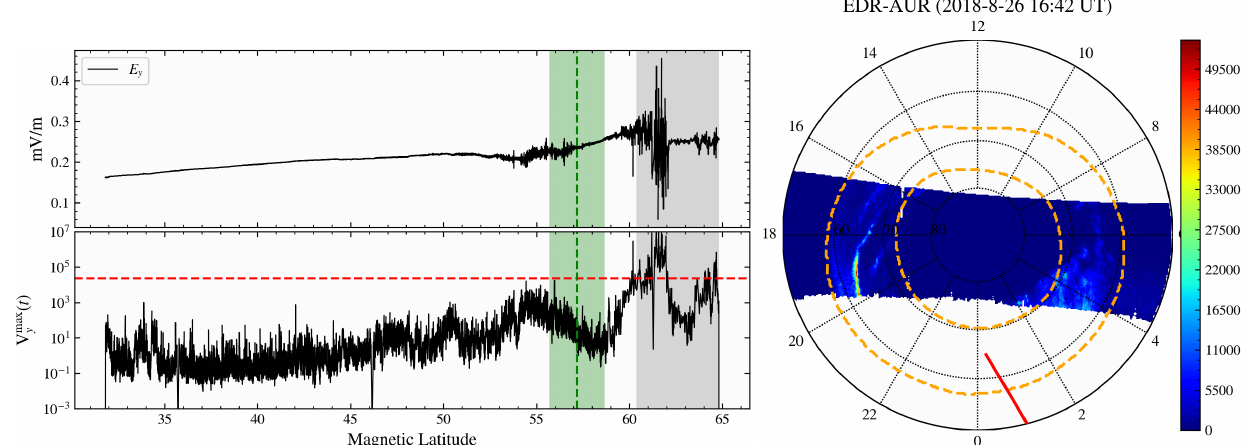
Figure 14. Same as Figure 7, except for orbit 3122. Negative detection, nightside northern hemisphere. Crossing not detected because of the